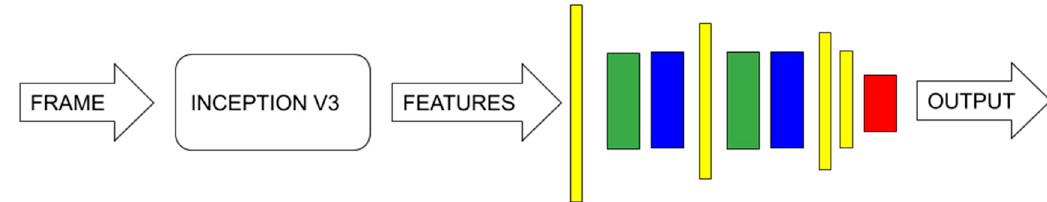
Figure 7. The frame passes through the inception v3 network from which the features that pass in the fully connected layer series (yellow rectangles) alternated by relay activation layers (green rectangles) and layer dropout (blue rectangles) are extracted from a sigmoid activation layer (red rectangle) [21].